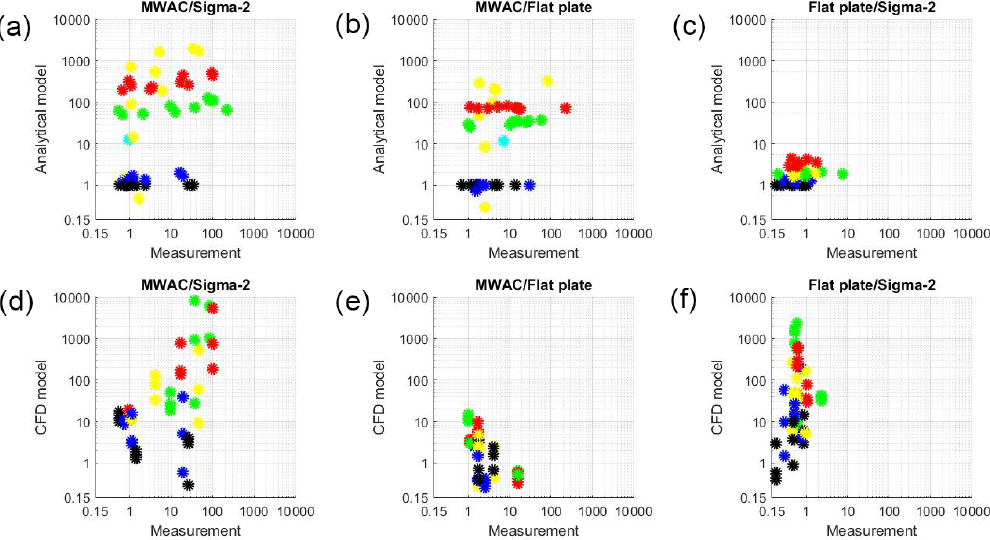
Figure 16. Comparison of the observed deposition velocity ratios with modeled ones by the analytical deposition models (a–c) and by the CFD models (d–f) . (a, d) MWAC/Sigma-2; (b, e) MWAC/flat plate; (c, f) flat plate/Sigma-2. Multiple daily measurements are shown in each plot. Different colors represent different size intervals: 1–2µm: black, 2–4µm: blue, 4–8µm: yellow, 8–16µm: red, 16–32µm: green, 32–64µm: